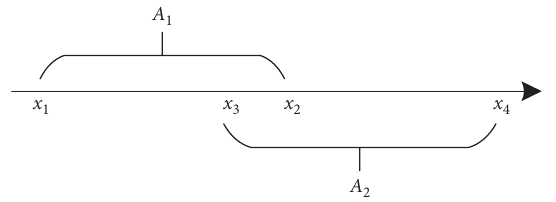
Figure 6: Schematic diagram of feasible solutions for one-di- mensional optimization problems.